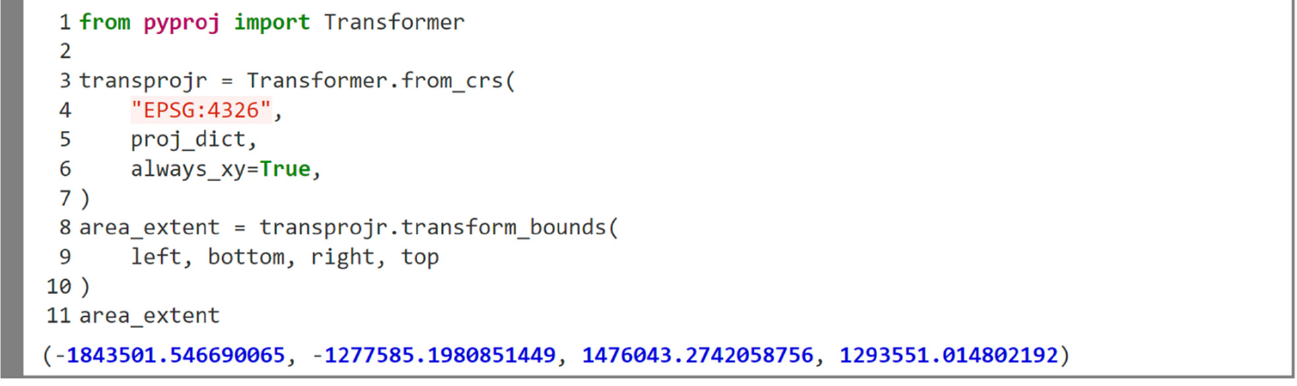
Figure A3. Python code snippet of transform_bounds used to convert the swath bounds to projected bounds while taking into account the nonlinearity of the transformations (https://pyproj4.github.io/pyproj/stable/api/transformer.html, accessed on 14 July 2022). EPSG:4326 is the Spatial Reference ID for the WGS84, latitude/longitude coordinate system based on the Earth’s center of mass.